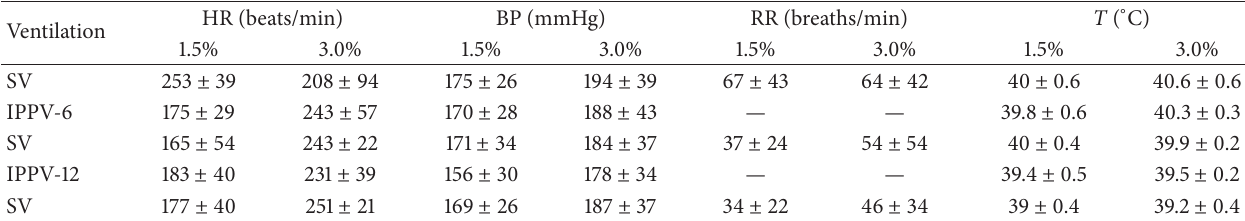
Table 3: Mean ± SD values for heart rate (HR), respiratory rate (RR), blood pressure (BP), and temperature ( 𝑇 ), measured during either spontaneous ventilation (SV) or intermittent positive pressure ventilation (IPPV) in 6 sulphur-crested cockatoos ( Cacatua galerita galerita ) during 1.5% and 3.0% isoflurane